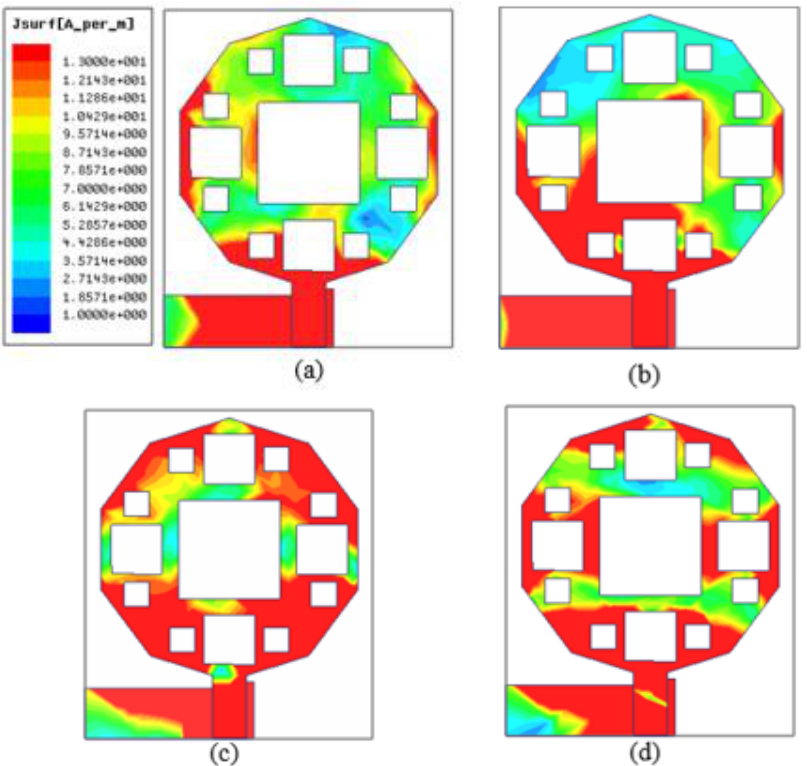
Figure 11. Surface current at ( a ) 5.8 GHz, ( b ) 8.7 GHz, ( c ) 10.9 GHz, ( d ) 13.2 GHz .